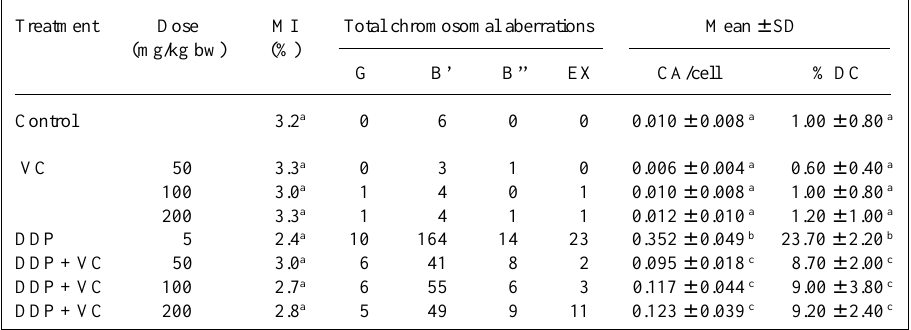
Table I - Mitotic indices, chromosomal aberrations and damaged bone marrow cells in the rats treated with vitamin C (VC) and/or cisplatin (DDP).